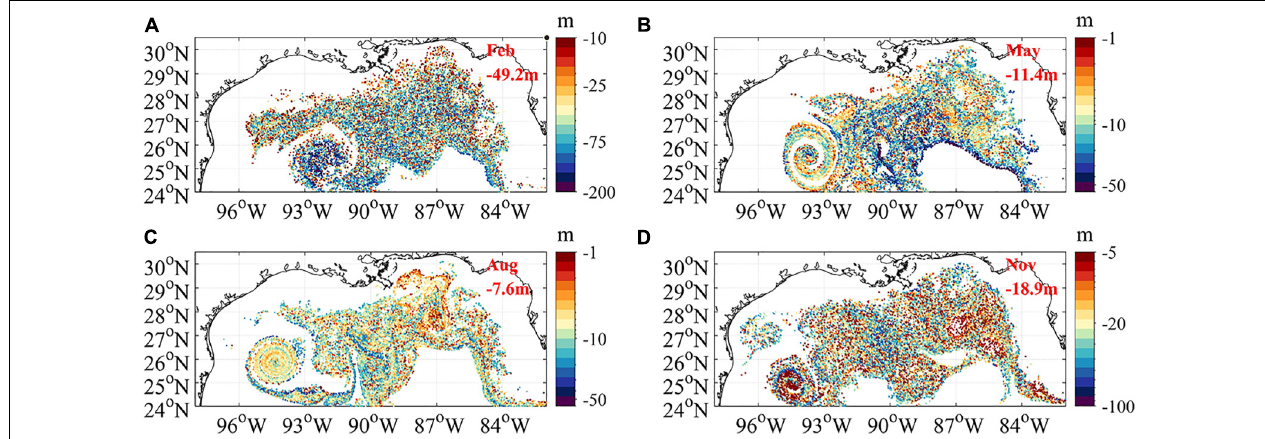
FIGURE 5 | Distribution of Lagrangian particles released at 5 m depth ( surface ) after 10 days in the SP simulation in February (A) , May (B) , August (C) , and November (D) . Color shading in logarithmic scale indicates the depth of each particle and varies across seasons. The mean depth of the particles on day 10 is also indicated. The particles plotted are from the first release in each